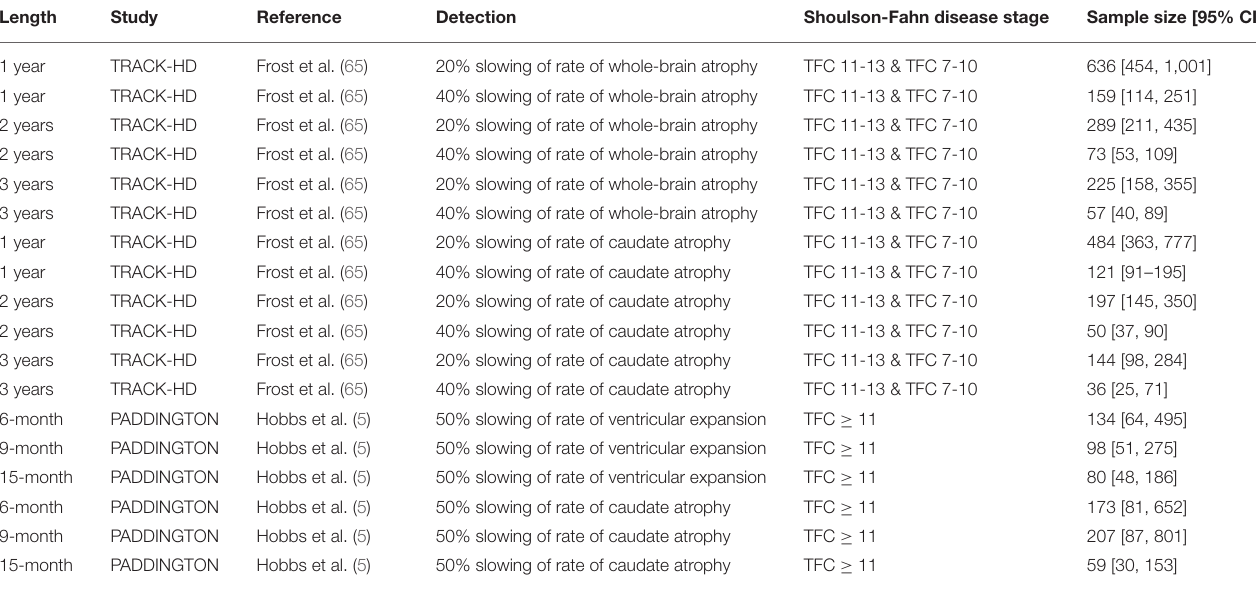
TABLE 3 | The estimated required sample sizes per arm to detect the specified change in different vMRI metrics from power calculations on TRACK-HD (65) and PADDINGTON (5) data.